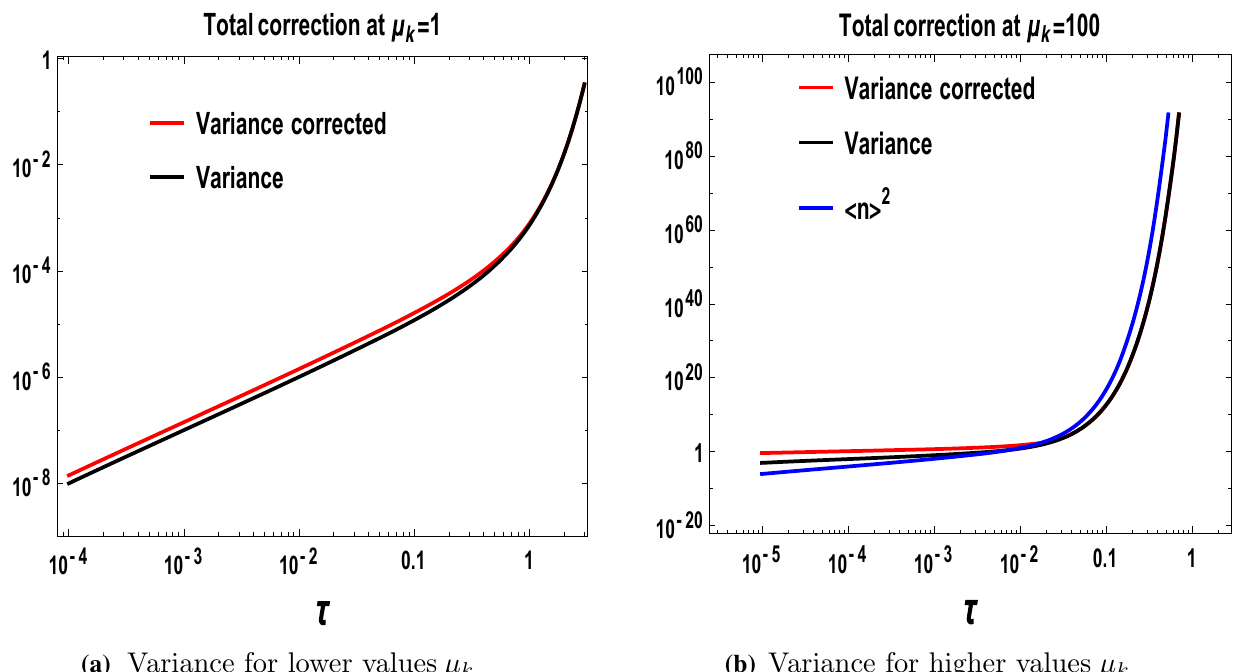
Fig. 52 Time dependent behaviour of variance without second order correction and with second order correction and (cid:14) n (cid:15) 2 are shown for different